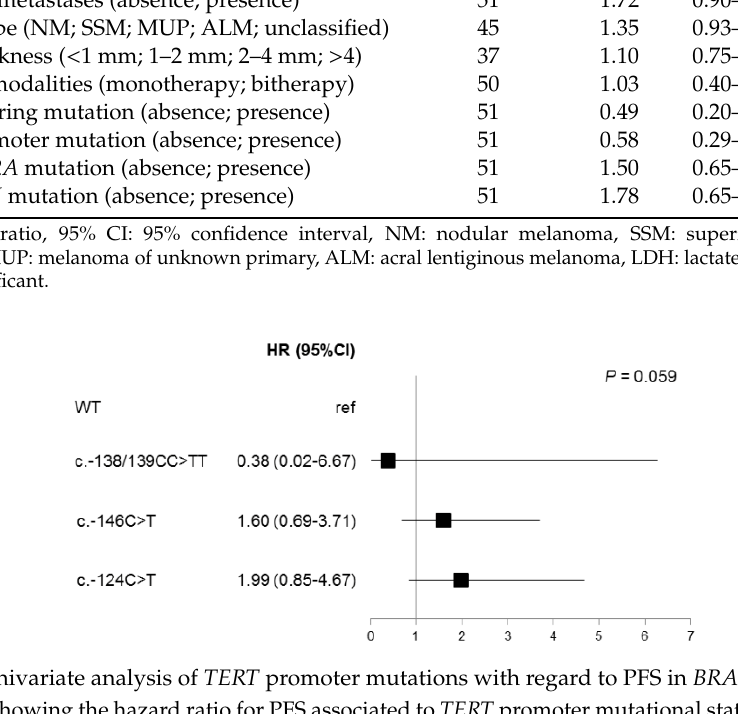
Table 3. Multivariate analysis of clinical parameters and TERT c.-124C>T mutational status with regard to PFS in BRAF V600 patients.